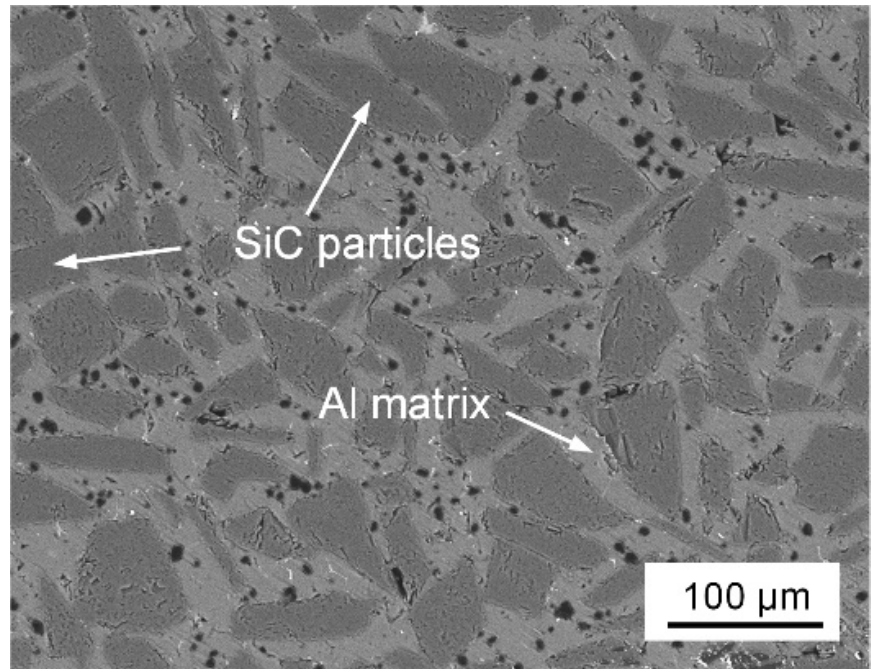
Figure 1. Microstructure of SiCp/Al composites.